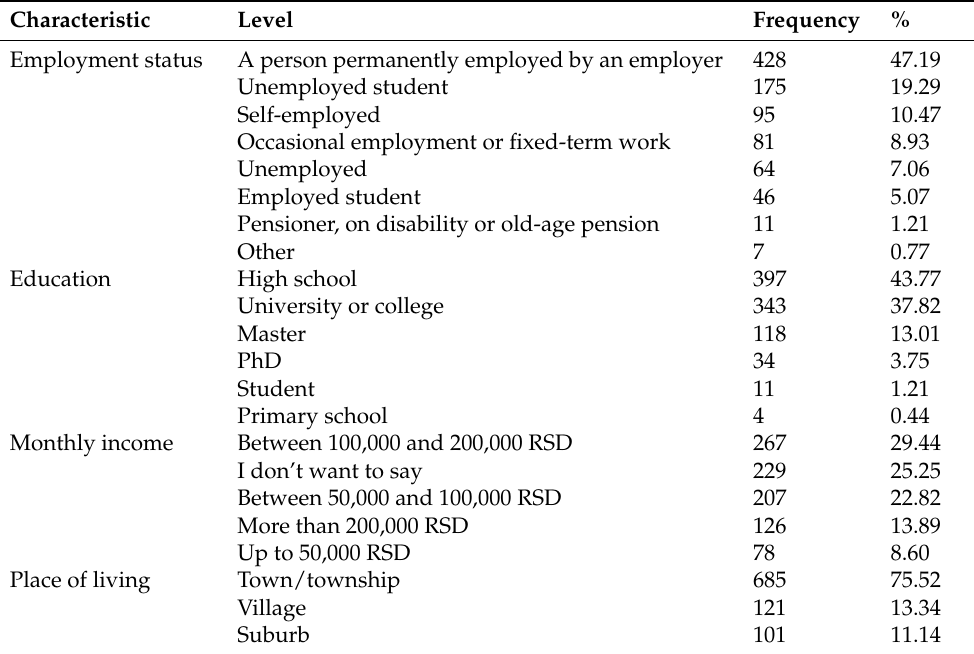
Table 1. Demographic characteristic of the sample (N =